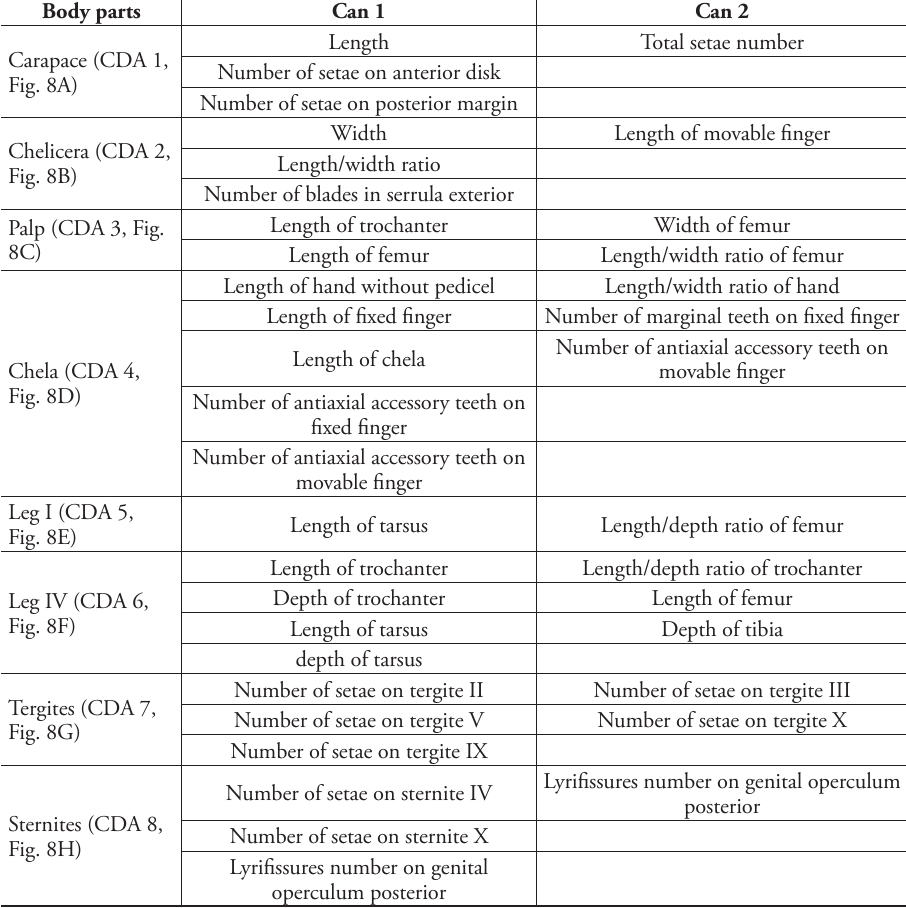
Table 2. Results of eight canonical discriminant analyses (CDA 1–CDA 8, Fig. 8) based on morphologi- cal characters measured/scored for 19 adult specimens and eight body parts of L . cretonatus , L . jonicus and L . pilosus . The characters which most strongly correlated with the canonical axes (Can 1, Can 2) are listed for each CDA. The extended version of the table, showing all the characters and total canonical structure, is given in Supplementary file